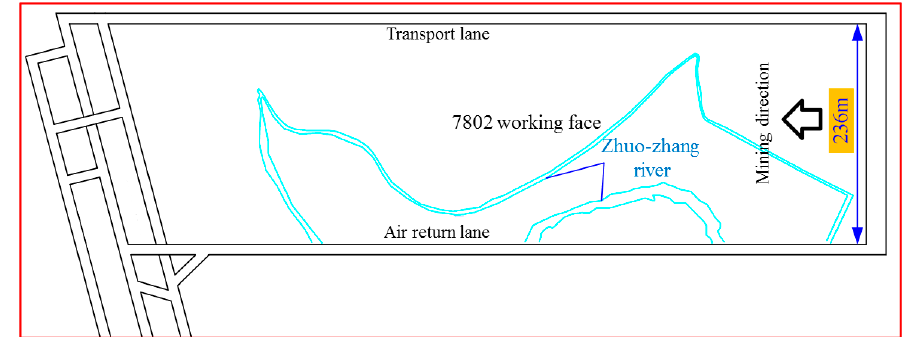
Figure 2. Schematic plan of the 7802 face.